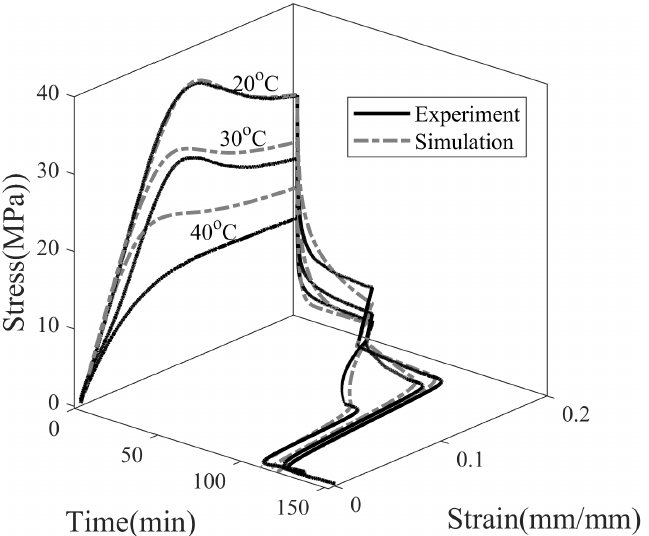
Figure 10. Thermomechanical behavior of SMP at programming temperatures, 20, 30, and 40 °C (with (cid:101) p = 0.2, t r = 45